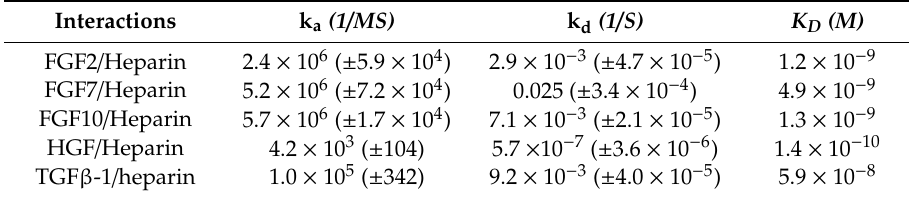
Table 1. Summary of kinetic data of growth factor-heparin interactions *.